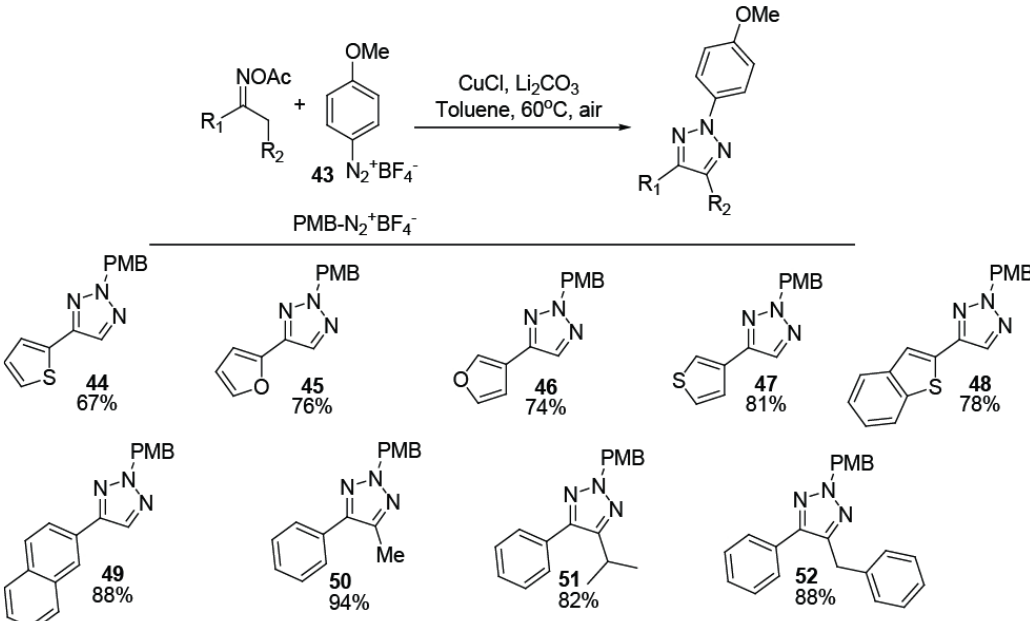
Figure 10 - The copper catalyzed oxidative cyclization between oximes and diazo compounds for the synthesis of N 2